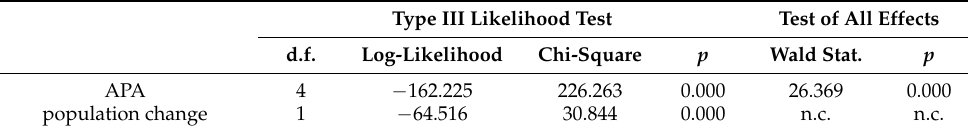
Table 5. Results of a non-parametric regression model for the new post-agricultural brownfields occurring after the year 2004 (Hosmer–Lemeshow = 2.661, p = 0.953; Cox–Snell pseudo R 2 = 0.636).